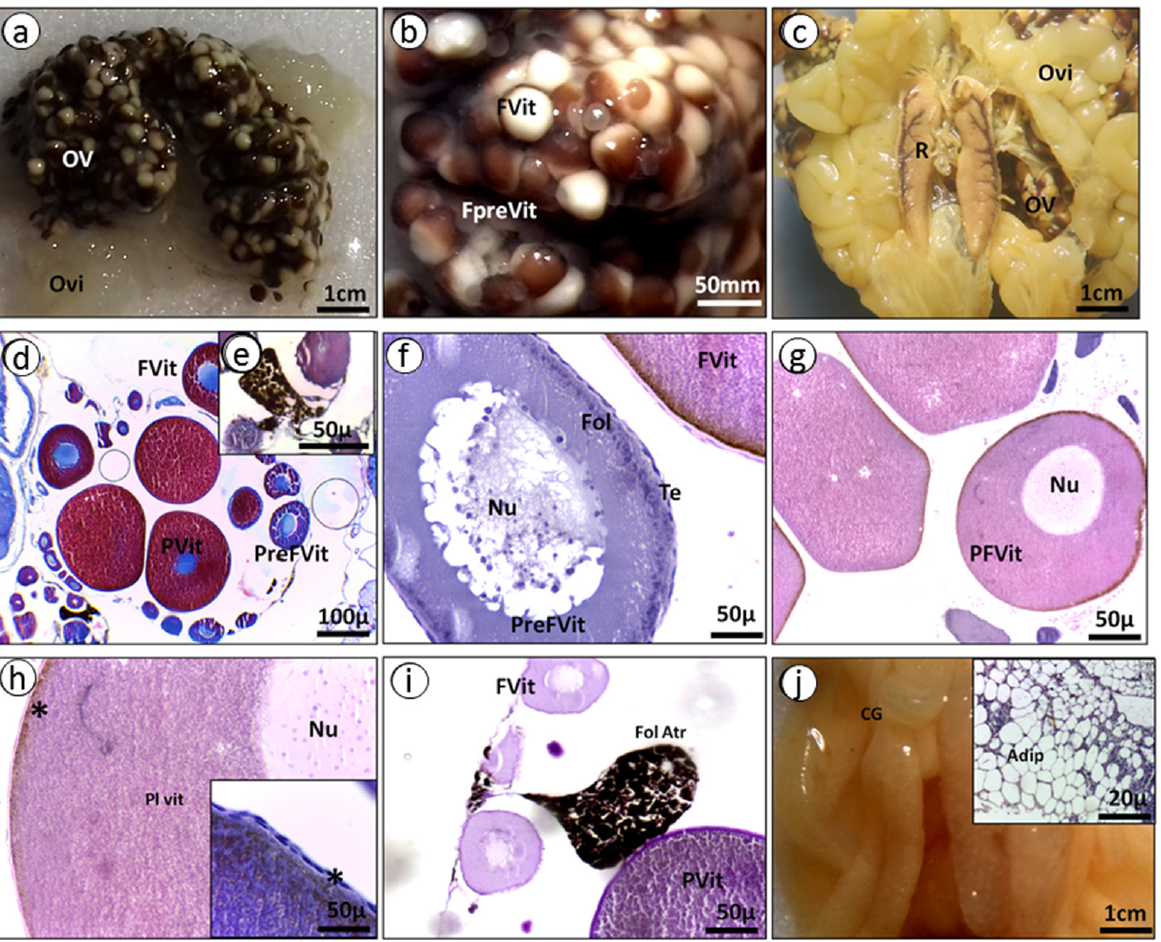
Figure 1. a) Detail of the ovary and oviduct of S. acuminatus. b) Detail of the cell types present in the ovary. c) Relationship between the position of the kidneys and the ovary and its vascularization. d) Transversal section of the ovary at the reproductive stage (Staining: Masson’s Trichrome). e) Detail of a pre-vitellogenic follicle (Staining: PAS). f) Atretic pre-vitellogenic follicle. g) Detail of a vitellogenic follicle (H-E Staining). h) Detail of post-vitellogenic follicle (Staining: H-E). i) Detail of an atretic and vitellogenic follicle (Staining: H-E) j) Fat bodies and detail in histological section (Staining: H-E). References: arrow: revetment epithelium. Ov: ovary. Ovi: oviduct. R: kidney. Fvit: vitellogenic follicle. FpreVit: Pre-vitellogenic follicle. Pvit: post-vitellogenic. Fol Atr: atretic follicle. Pl vit: viteline platelets. Nu: nucleus. Fol: follicular cells (*). Te: tecal cells, CG: fat body. Adip: adipocytes. Mes: